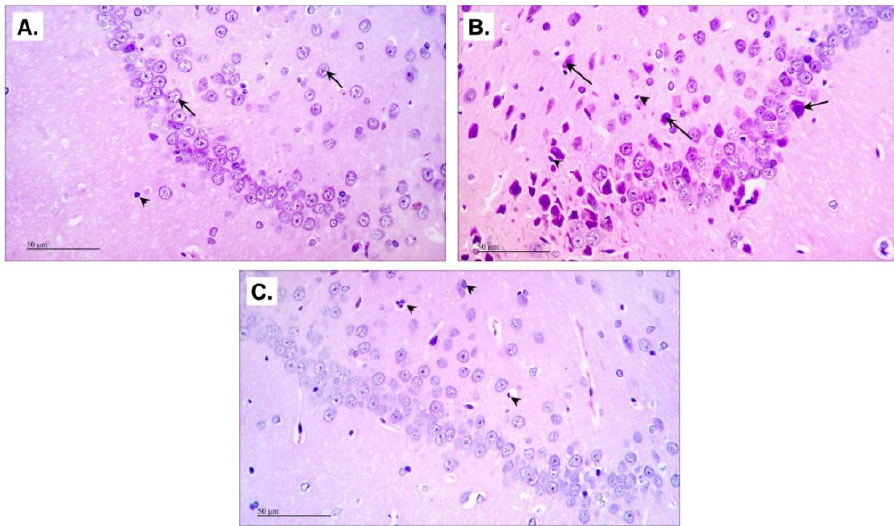
Figure 6. CDCA preserves normal histological features in AD rat model. The figure shows H&E photomicrographs of hippocampus CA1 region. ( A ) Control (arrows = intact neurons with vesicular nuclei; arrow-heads = glial cells), ( B ) AD-model group (arrows = degenerated neurons; arrow-heads = glial infiltration) and ( C ) CDCA-treated group (arrow-heads = glial infiltration). The figure scale bar = 50 µ m. AlCl 3 : aluminum chloride; CA1: Cornu Ammonis 1; CDCA: chenodeoxycholic acid; H&E: Harris Hematoxylin and Eosin.